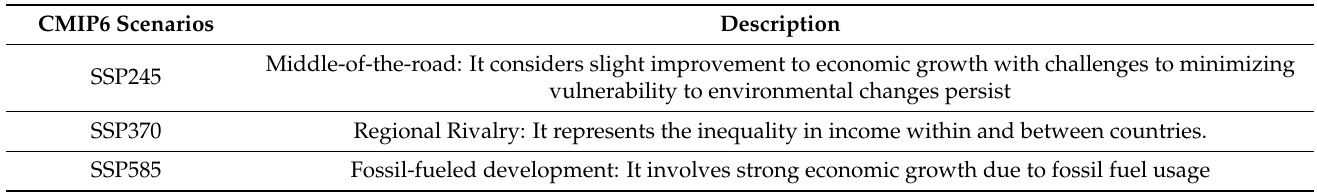
Table 2. Summary of the selected CMIP6 scenarios for the